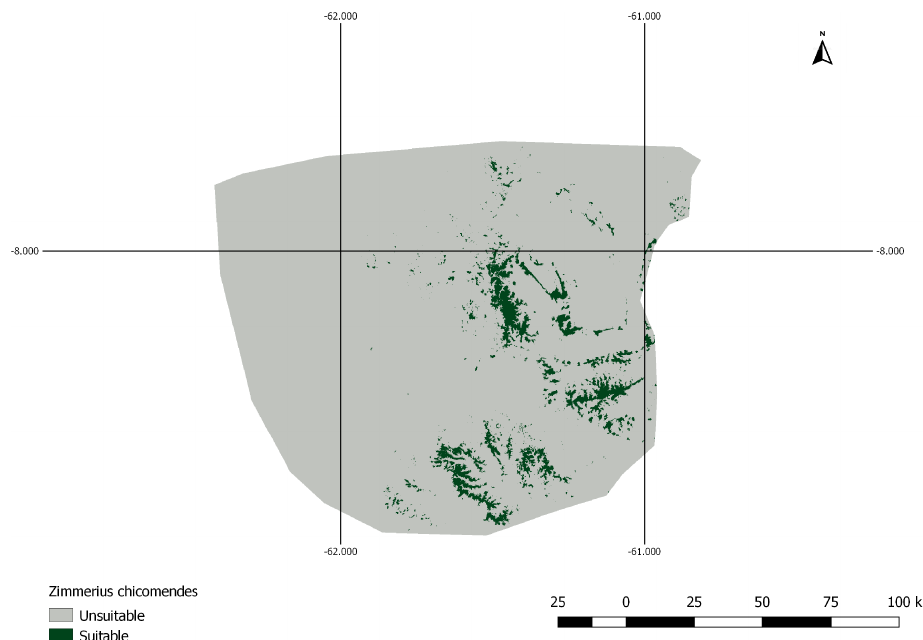
Figure A1. AOH map for species Zimmerius chicomendesi . The species is coded against “forest” and “shrubland” habitats and the elevation range falls inside the IUCN range. However, the land cover inside this range map includes a high proportion of “herbaceous cover” land cover type which is not associated with “shrubland” habitat in the habitat-land cover association table. Therefore, the model prevalence of this AOH is much lower than expected.